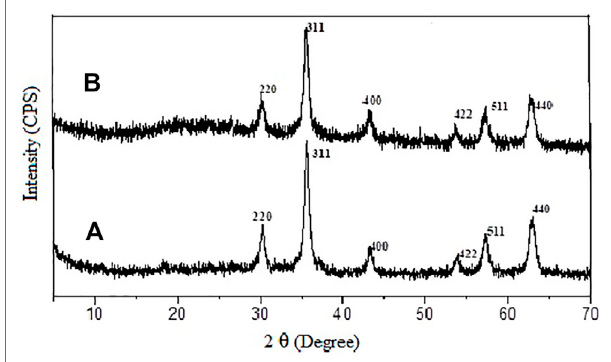
FIGURE 4 | X-ray diffraction patterns of (A) MNPs and (B)